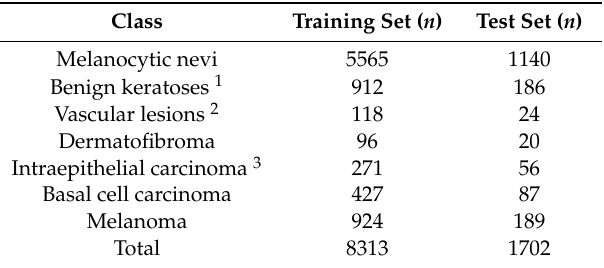
Table 1. Description of the training and test